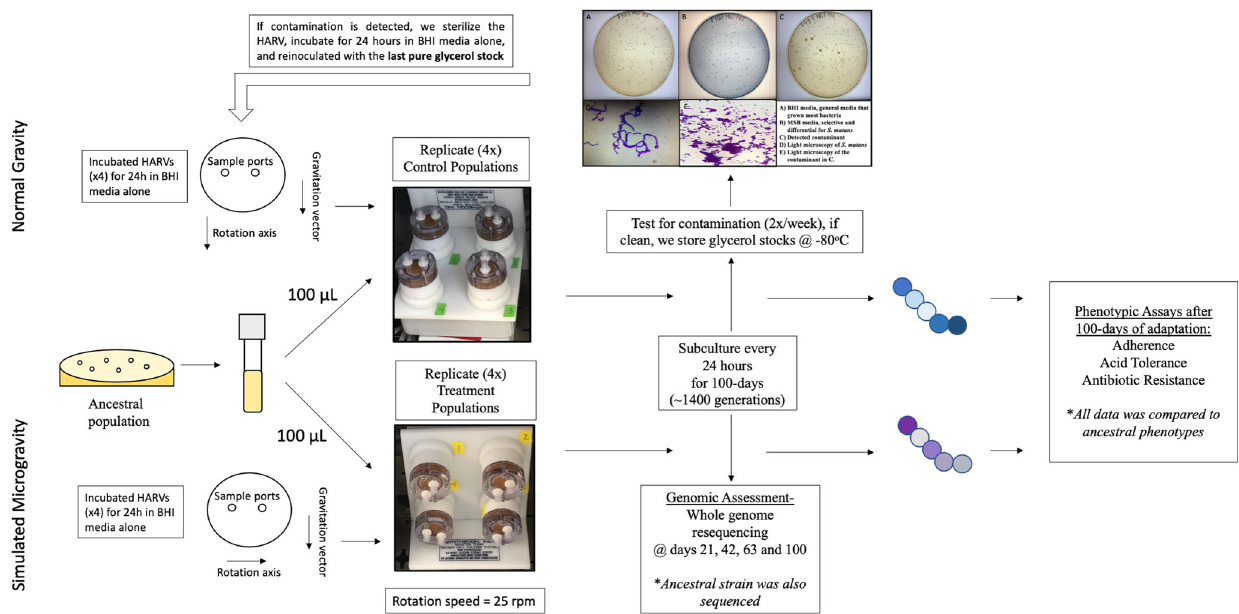
Fig. 1 Experimental methods. Schematic representation of the experimental evolution work fl ow used to adapt Streptococcus mutans to simulated